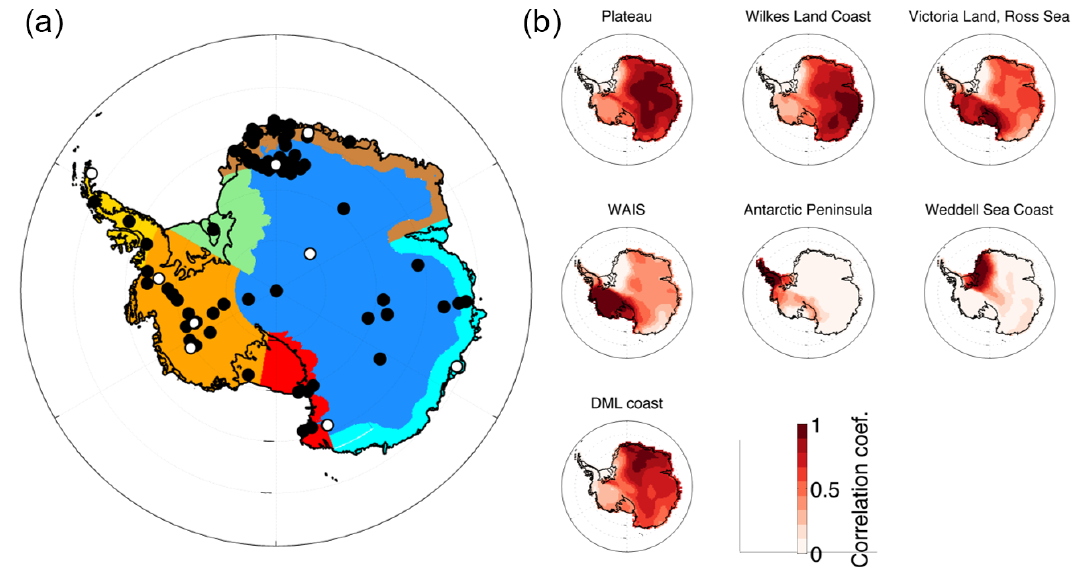
Figure 1. (a) Schematic map of the seven Antarctic regions selected for the regional reconstructions. In blue is the East Antarctic Plateau, in light blue the Wilkes Land Coast, in green the Weddell Sea Coast, in yellow the Antarctic Peninsula, in orange the West Antarctic Ice Sheet, in red the Victoria Land Coast–Ross Sea and in brown the Dronning Maud Land Coast. The dots show the site locations. The white dots represent the sites that have been used in the previous continent-scale reconstruction (PAGES 2k Consortium, 2013). (b) Correlation maps between the regional mean temperature and each grid point using the Nicolas and Bromwich (2014) data